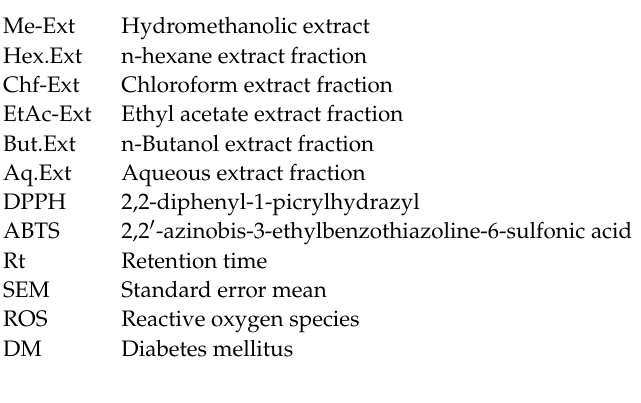
Supplementary Materials: The following are available online, Figure S1. Structural formula of compound-I (Morin), Figure S2. FTIR spectra of compound- I (Morin), Figure S3. 1 H NMR (Acetone, 300MHz) of compound- I (Morin), Figure S4. 13 C NMR (Acetone, 75 MHz) of compound-I (Morin), Figure S5. EIMS of compound-I (Morin), Figure S6. Structural formula of compound- II (Phlorogluci- nol), Figure S7. FTIR spectra of compound- II (Phloroglucinol), Figure S8. 1H- (Methanol, 500 MHz) of compound- II (Phloroglucinol), Figure S9. 13 C-NMR (Methanol, 126 MHz) of compound- II (Phloroglucinol), Figure S10. EI-MS Mass of compound- II (Phloroglucinol), Figure S11. Structural formula of compound- III (1-Hexyl benzene), Figure S12. 1 H NMR (DMSO- H 2 O, 300MHz) of compound- III (1-Hexyl benzene), Figure S13. 13 C NMR (DMSO-d6, 75MHz) of compound- III (1- Hexyl benzene), Figure S14. FTIR spectra of compound- III (1-Hexyl benzene), Figure S15. EIMS of compound- III (1-Hexyl